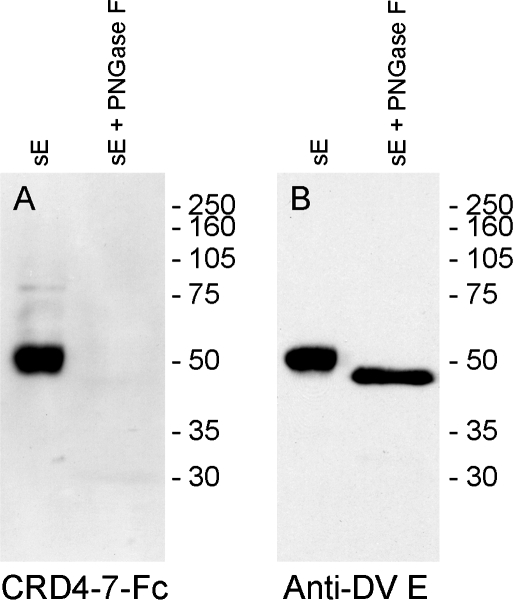
MR CRD4-7-Fc Binds Specifically to sE in Blot Overlay, and Binding Depends on N-Linked SugarssE and PNGaseF-treated sE were resolved by SDS-PAGE using 10% gels, transferred to nitrocellulose membranes, and (A) probed with MR CRD4–7-Fc. (B) Blots were subsequently stripped and reprobed with the anti-E protein antibody, 3H5.